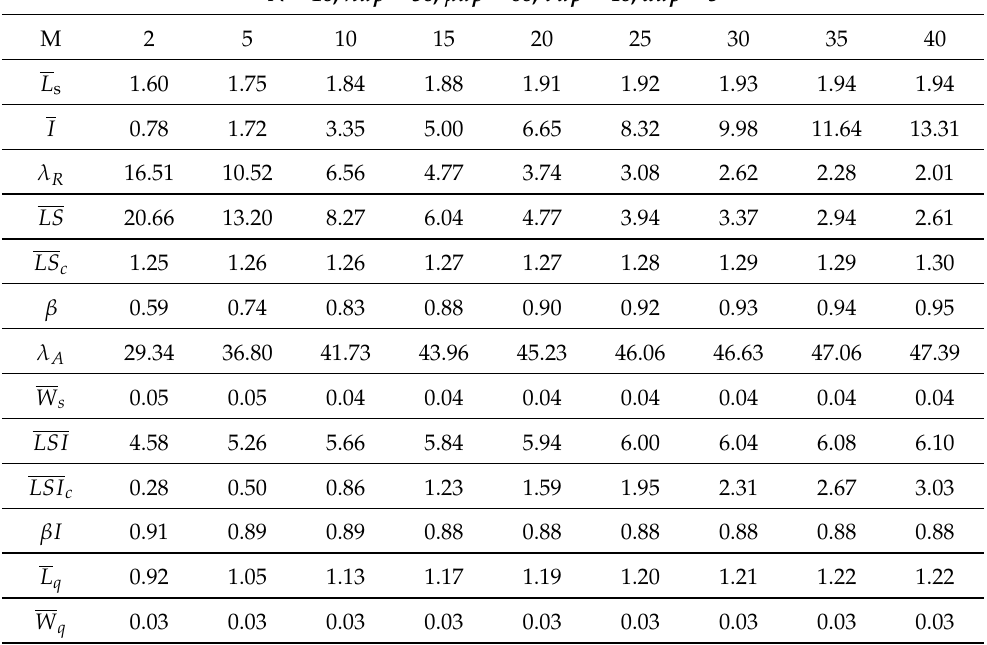
Table 5. Effect of changing the order quantity on the performance measures considering that the maximal capacity of the system is 10 and the maximal capacity of the inventory is variable with impatient customers under a uniform order size.